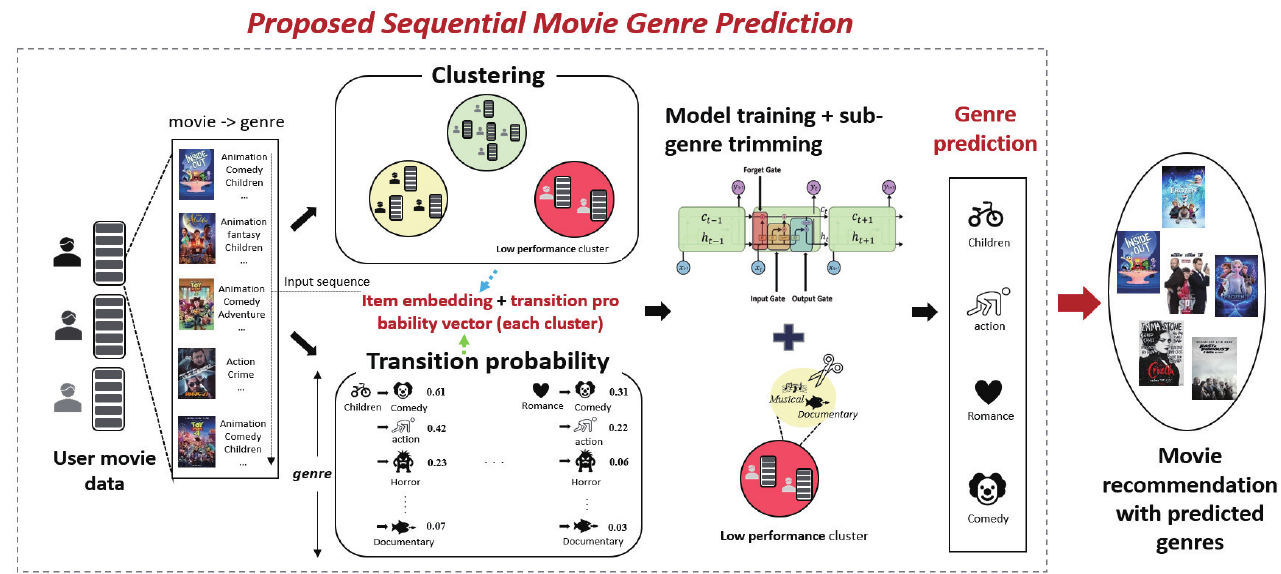
Figure 2. Overall view of our proposed sequential movie genre